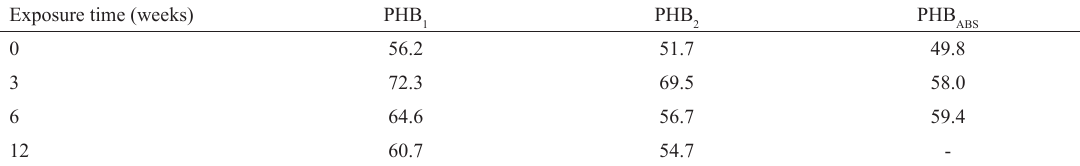
) of PHB , PHB and PHB before and after exposure to UV radiation for different times. c 1 2 ABS